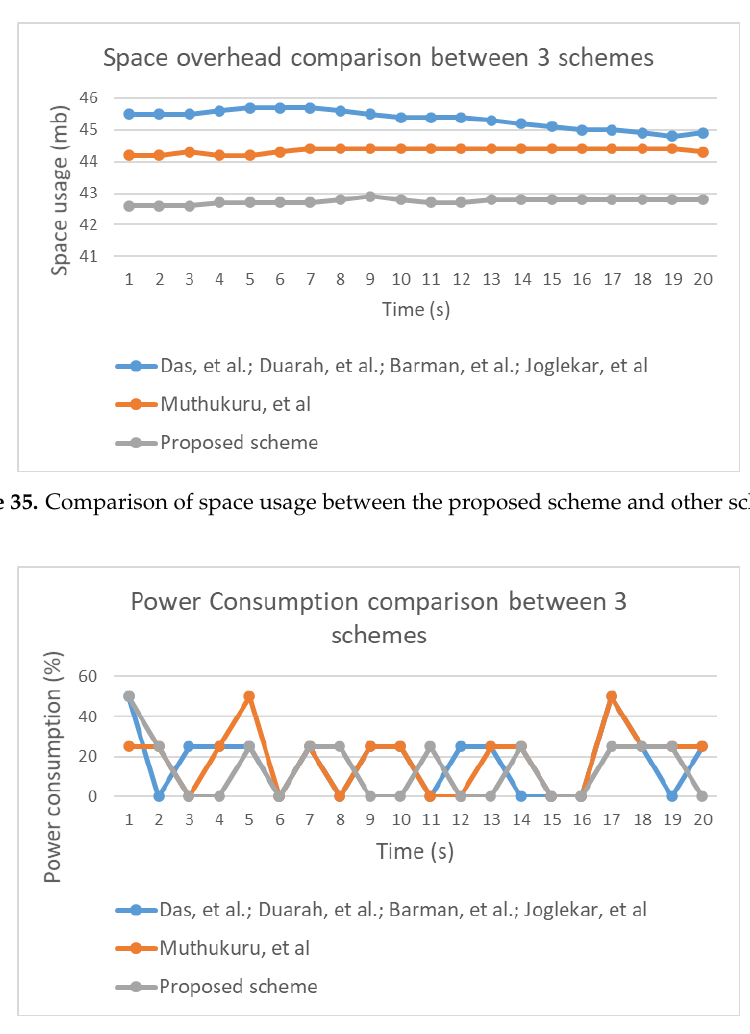
Figure 36. Comparison of power consumption between the proposed scheme and other